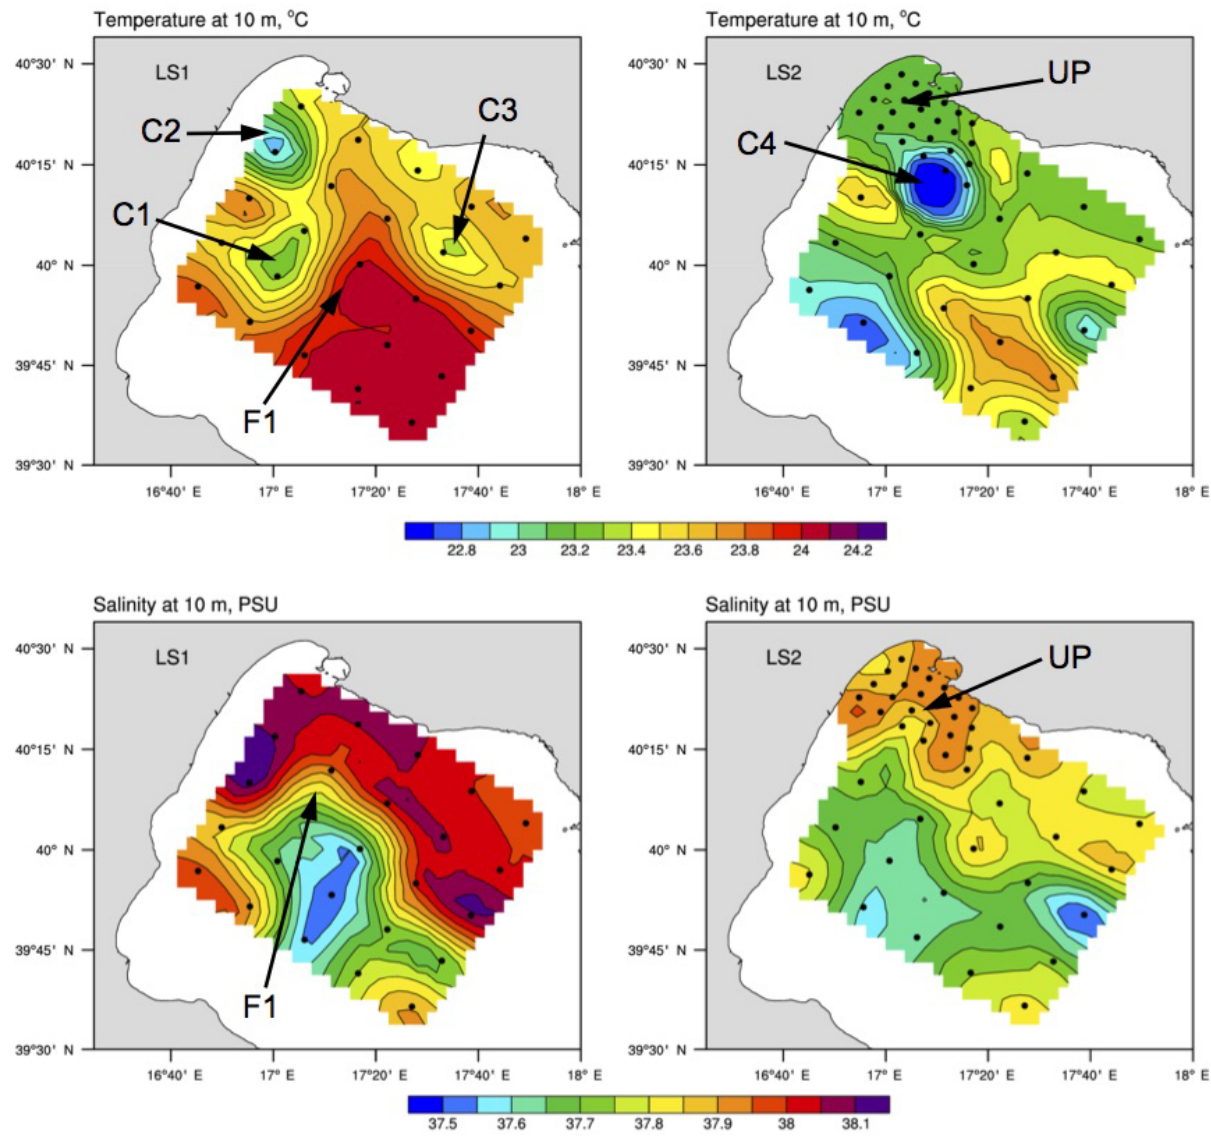
Figure 10. Temperature and salinity objective mapping at 10m. Left top and bottom panel: LS1 temperature and salinity fields. Right top and bottom panel: LS2 temperature and salinity fields. Symbols indicate four cold core eddies (C1, C2, C3, C4), the temperature and salinity front (F1) and the upwelling area